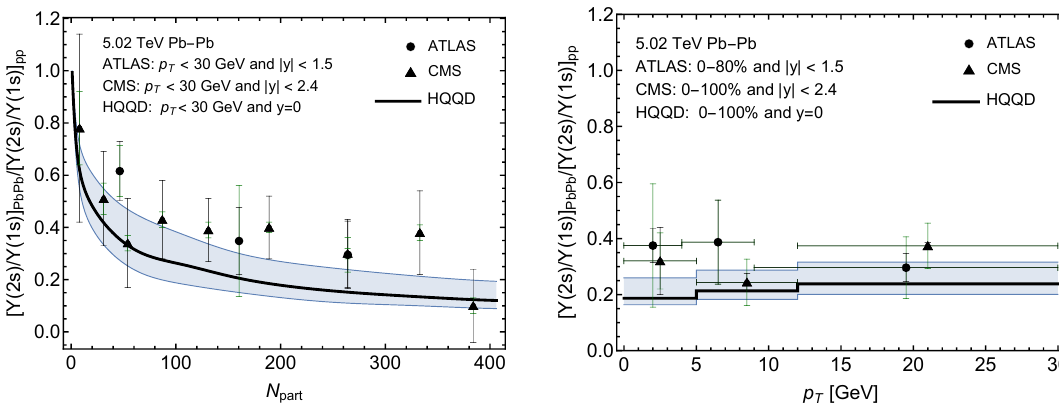
Figure 2 . Double ratio [Υ(2 s ) / Υ(1 s )] PbPb / [Υ(2 s ) / Υ(1 s )] pp as a function of N part (left panel) and p (right panel). The solid line shows the prediction of HQQD. The shaded bands indicate T the variation of the HQQD result when changing the model parameters in the range specified in eq. (6.1). The data points are from the ATLAS [79] and CMS [80] collaborations. Systematic and statistical experimental uncertainties are indicated by the green and black error bars,